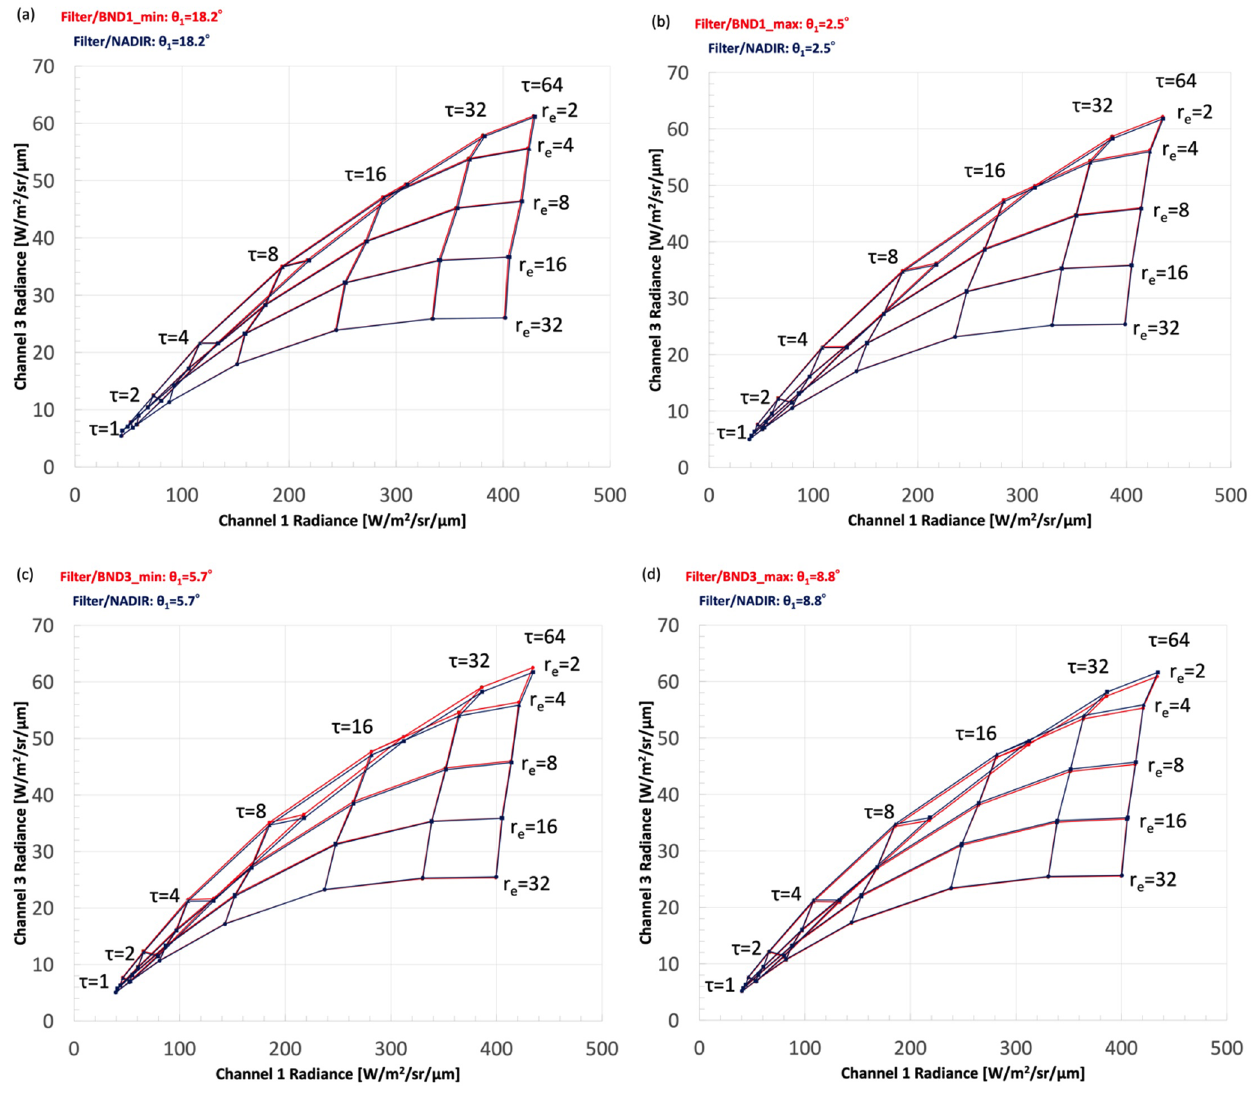
Figure 4. Nakajima–King diagrams for shallow warm clouds at (a) pix_BND1_min, (b) pix_BND1_max, (c) pix_BND3_min, and (d) pix_BND3_max for a solar zenith angle of 20 ◦ . The red lines show the results from the response function with SMILE. The black lines show the results from the nadir response